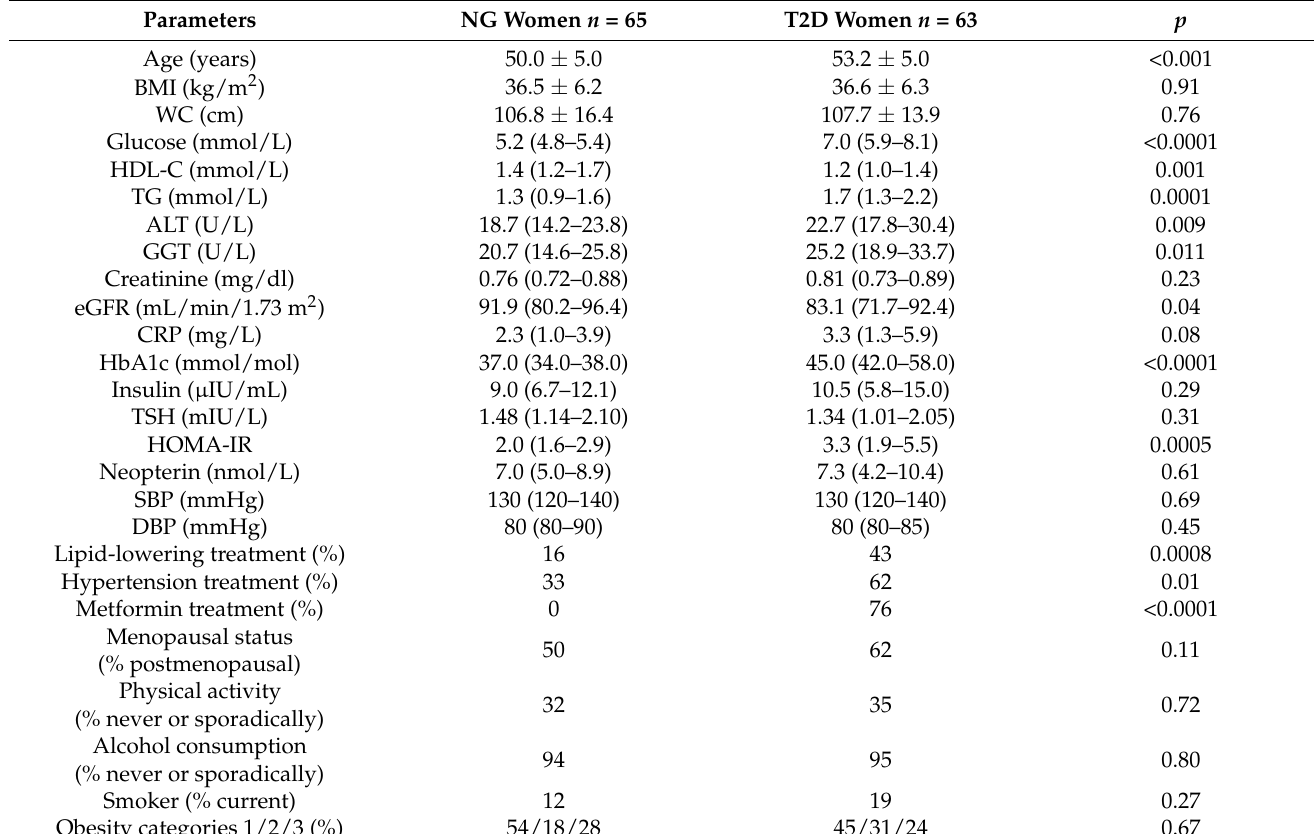
Table 1. The basal characteristics of obese normoglycemic (NG) and T2D